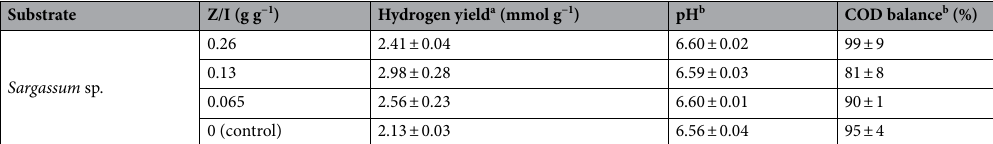
with and Χ without zeolite. ●